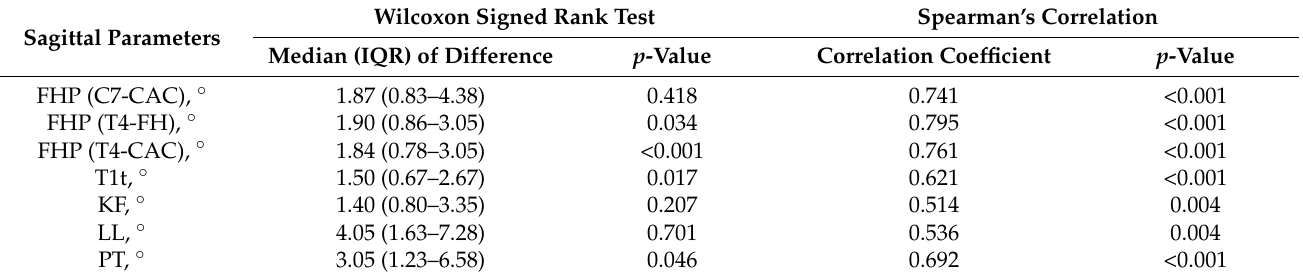
Table 4. Accuracy and correlation of sagittal parameters measurements between EOS imaging system and